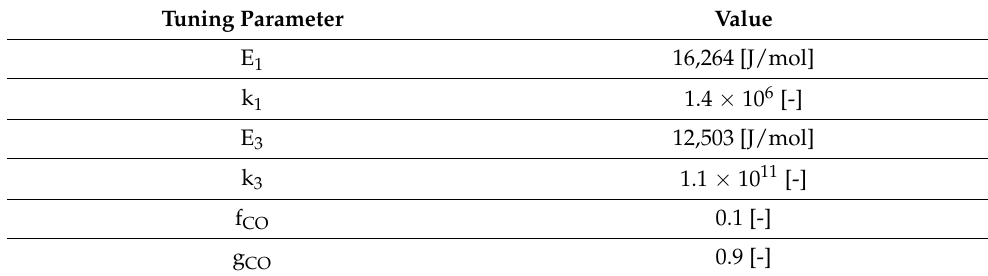
Table 11. Optimized values of the DPF tuning parameters.